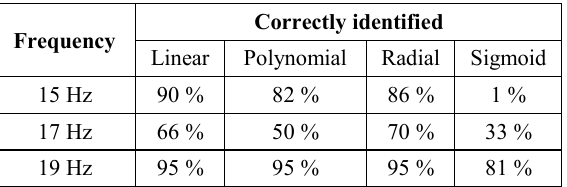
Table 3. C-SVM classifier test results.